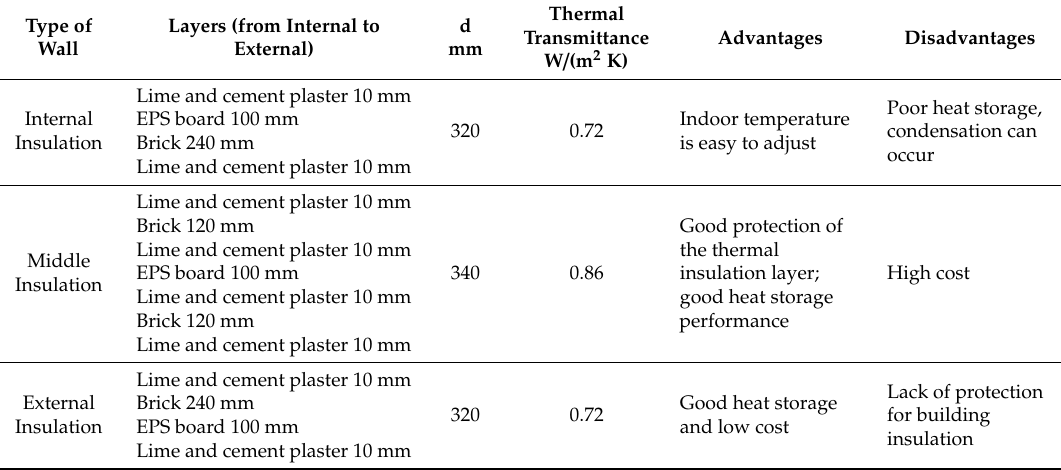
Table 1. Comparison of di ff erent types of wall insulation.